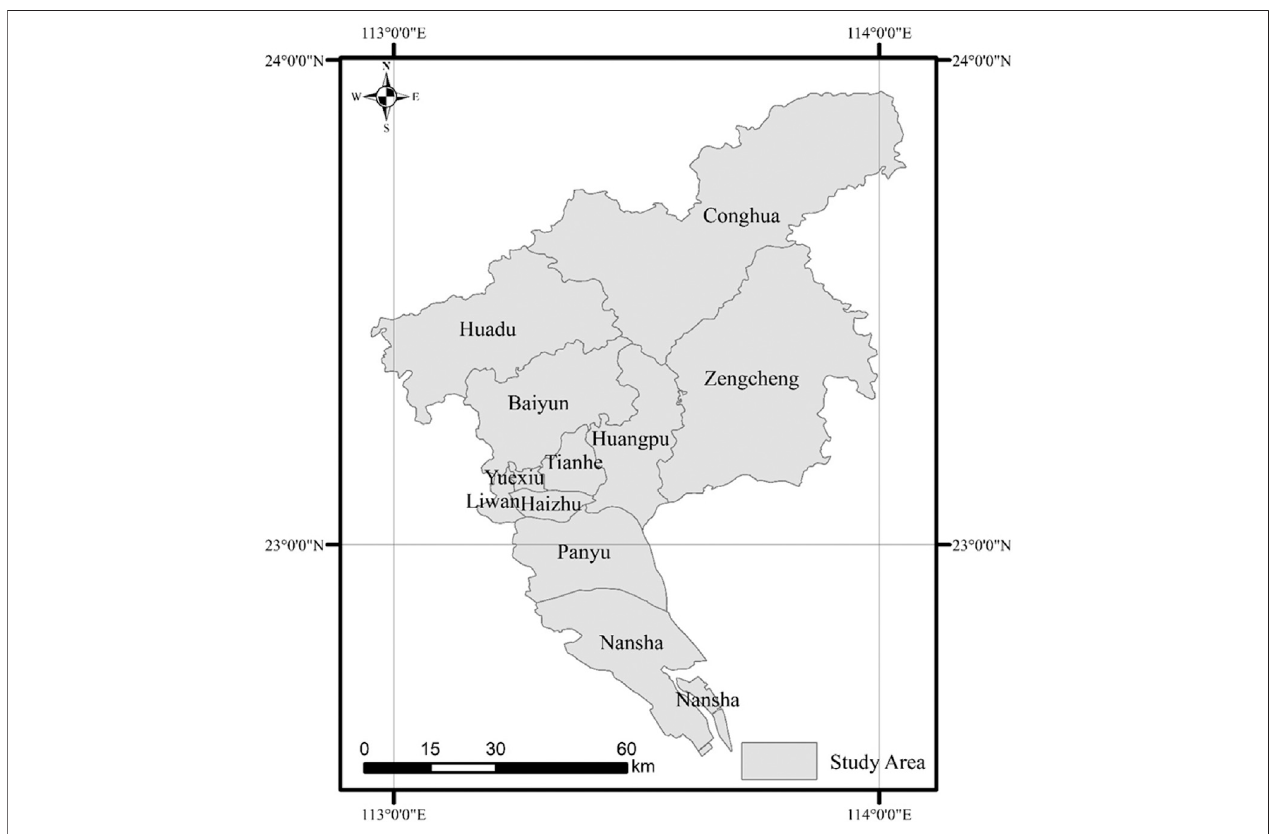
FIGURE1| Studyarea(thestudyareaisGuangzhouCity,GuangdongProvince,China,whichislocatedonthesoutherncoastofChinaandisoneofthecitieswith the highest level of urbanization and modernization in China).